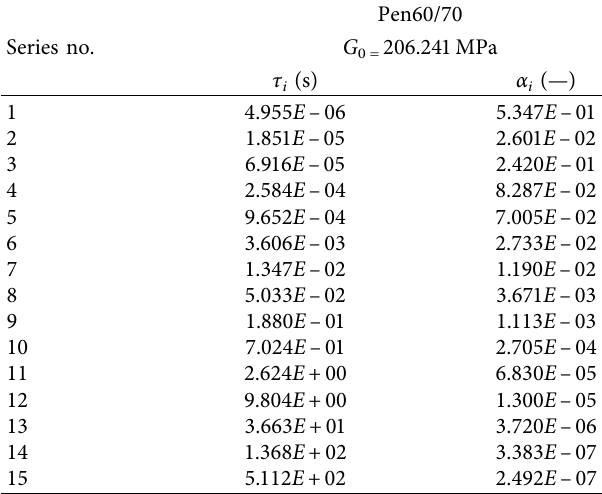
Table 4: Prony series model parameters of asphalt binder at 25 ° C. Series